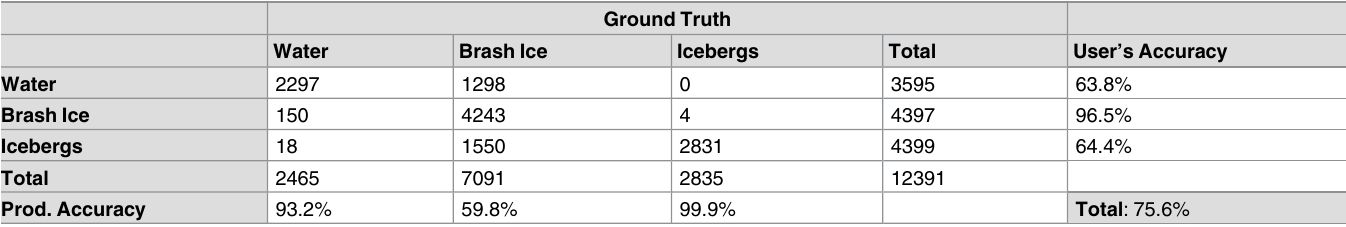
Table 3. Summary of classification error analysis results.